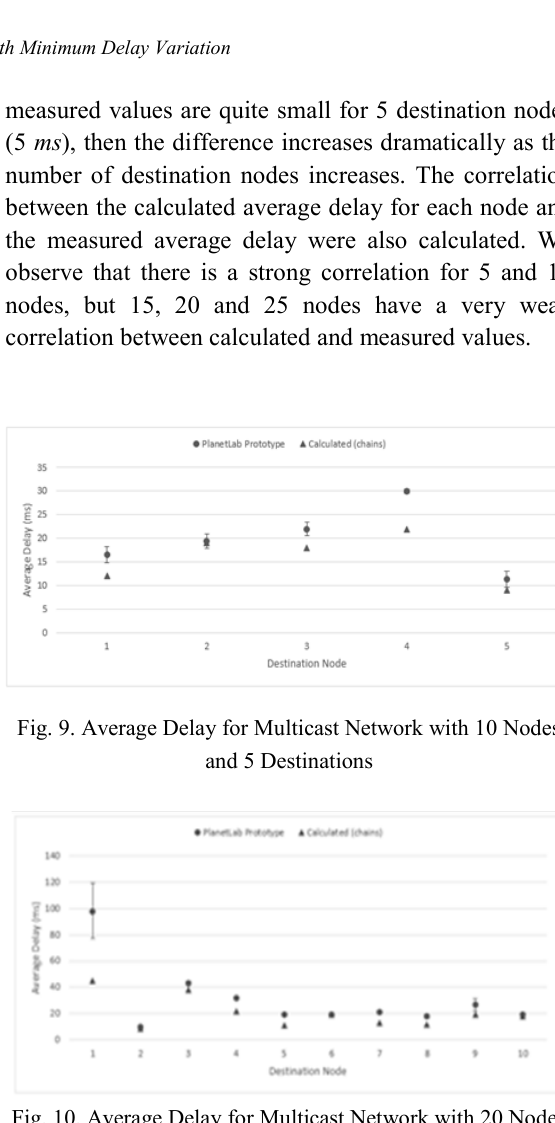
Fig. 10. Average Delay for Multicast Network with 20 Nodes and 10 Destinations